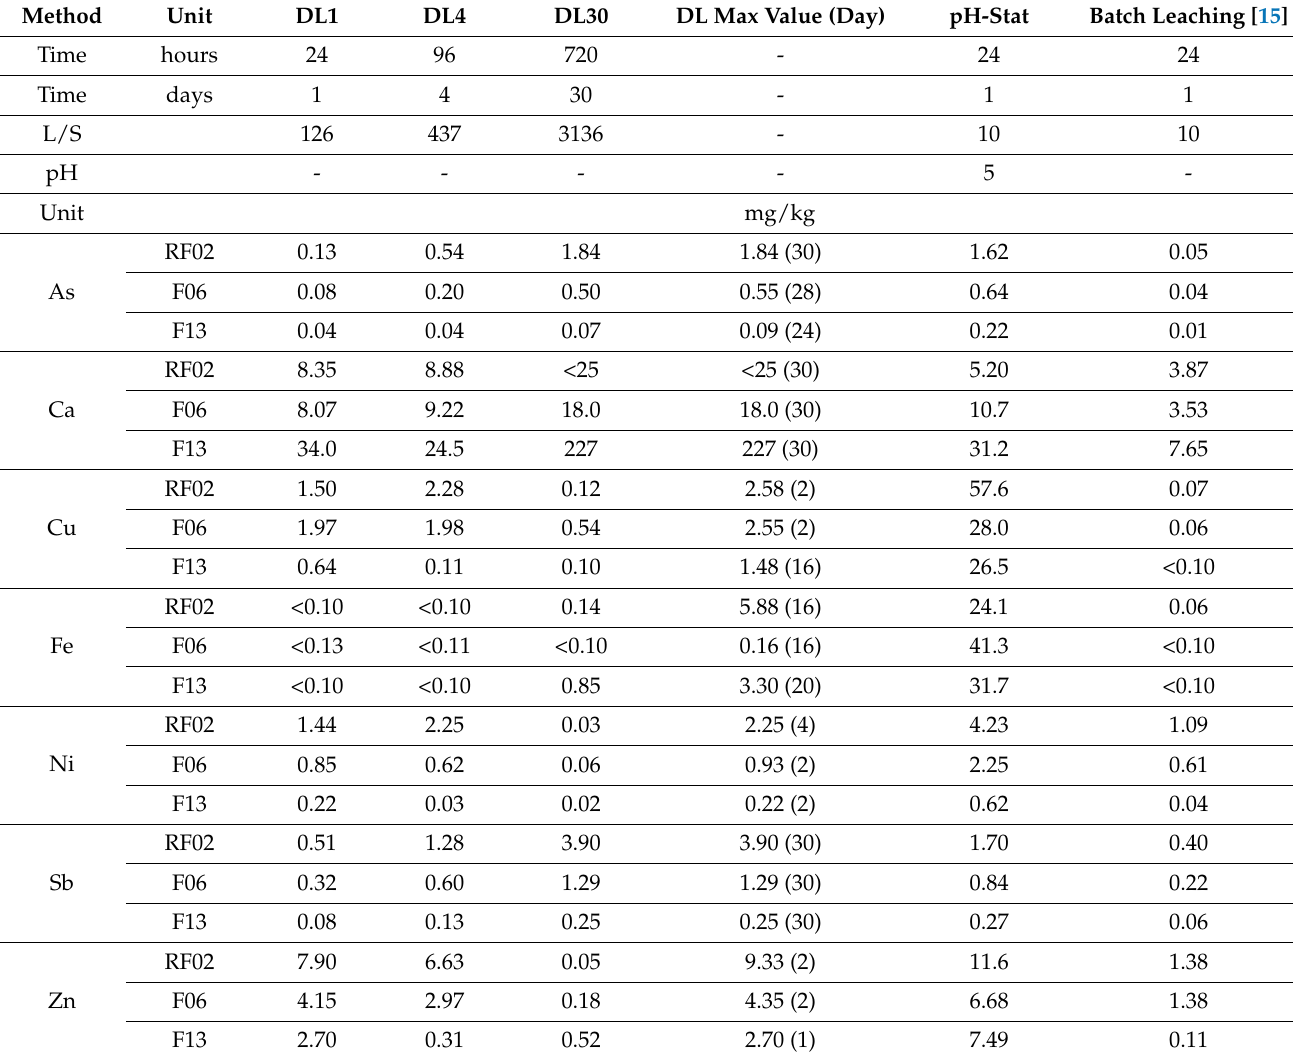
Table 5. Leaching comparison (mg/kg) for leachates measured according to batch leaching, dynamic leaching (DL) on days 1, 4, and 30, and maximum leaching values (day); static pH titration at pH 5